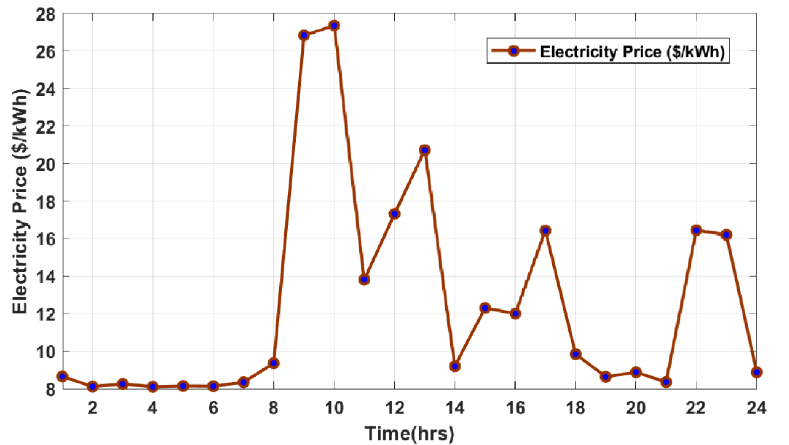
Figure 7. Hourly Electricity Price